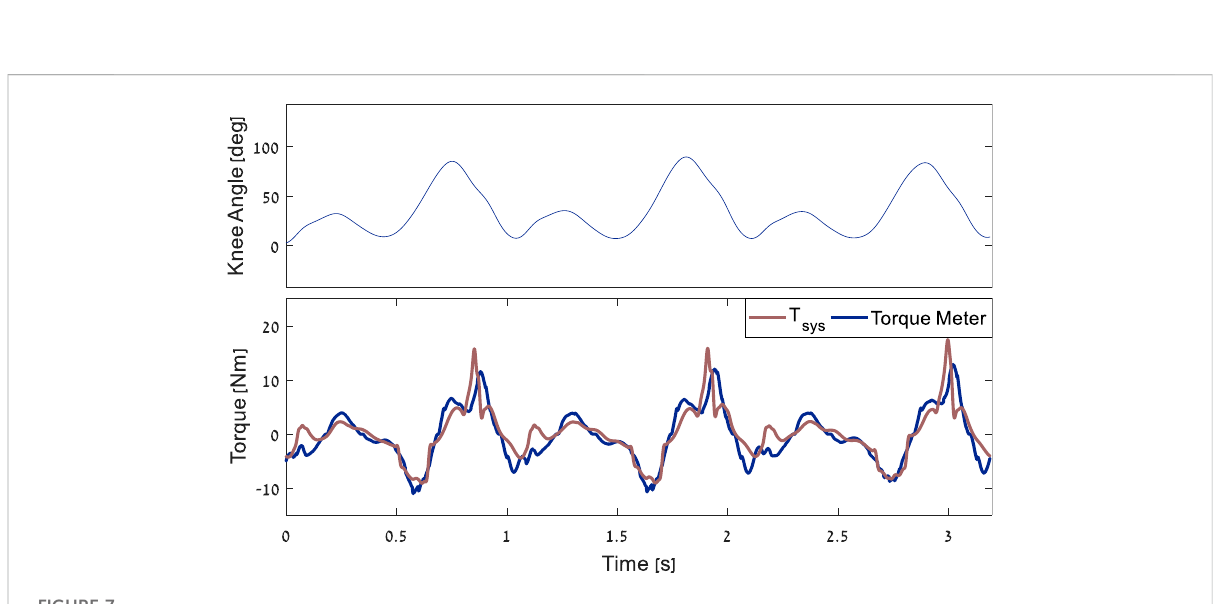
FIGURE 7 Example of the comparison between the torquemeter results and the model over three gait cycles. T sys is the predicted torque that the system applies on the